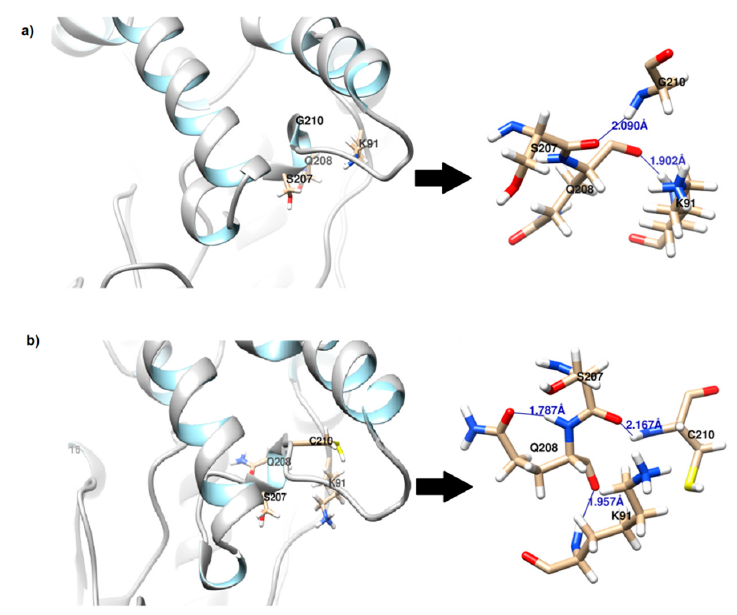
Figure 2. Local hydrogen bond between residue 210 and its neighboring residues as observed in ( a ) rT-M386 and ( b ) mutant G210C. An additional intraresidue hydrogen bond is formed at Q208 in mutant G210C with a distance of 1.787 Å.